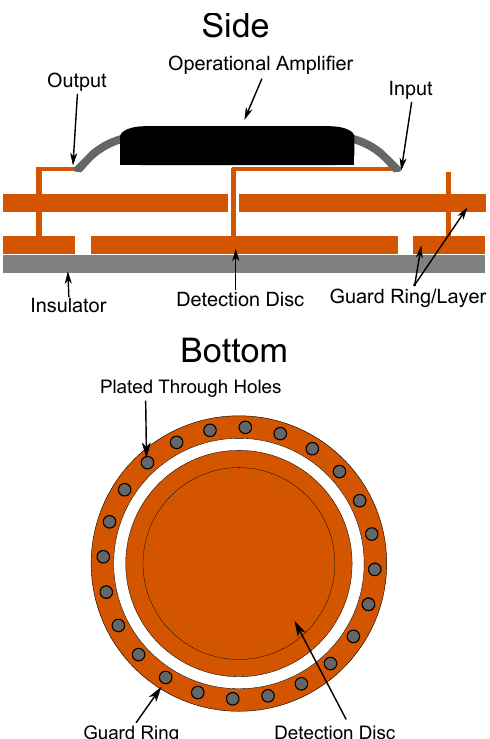
Figure 1. Diagram of the layers of the basic design of a capacitive sensor on a